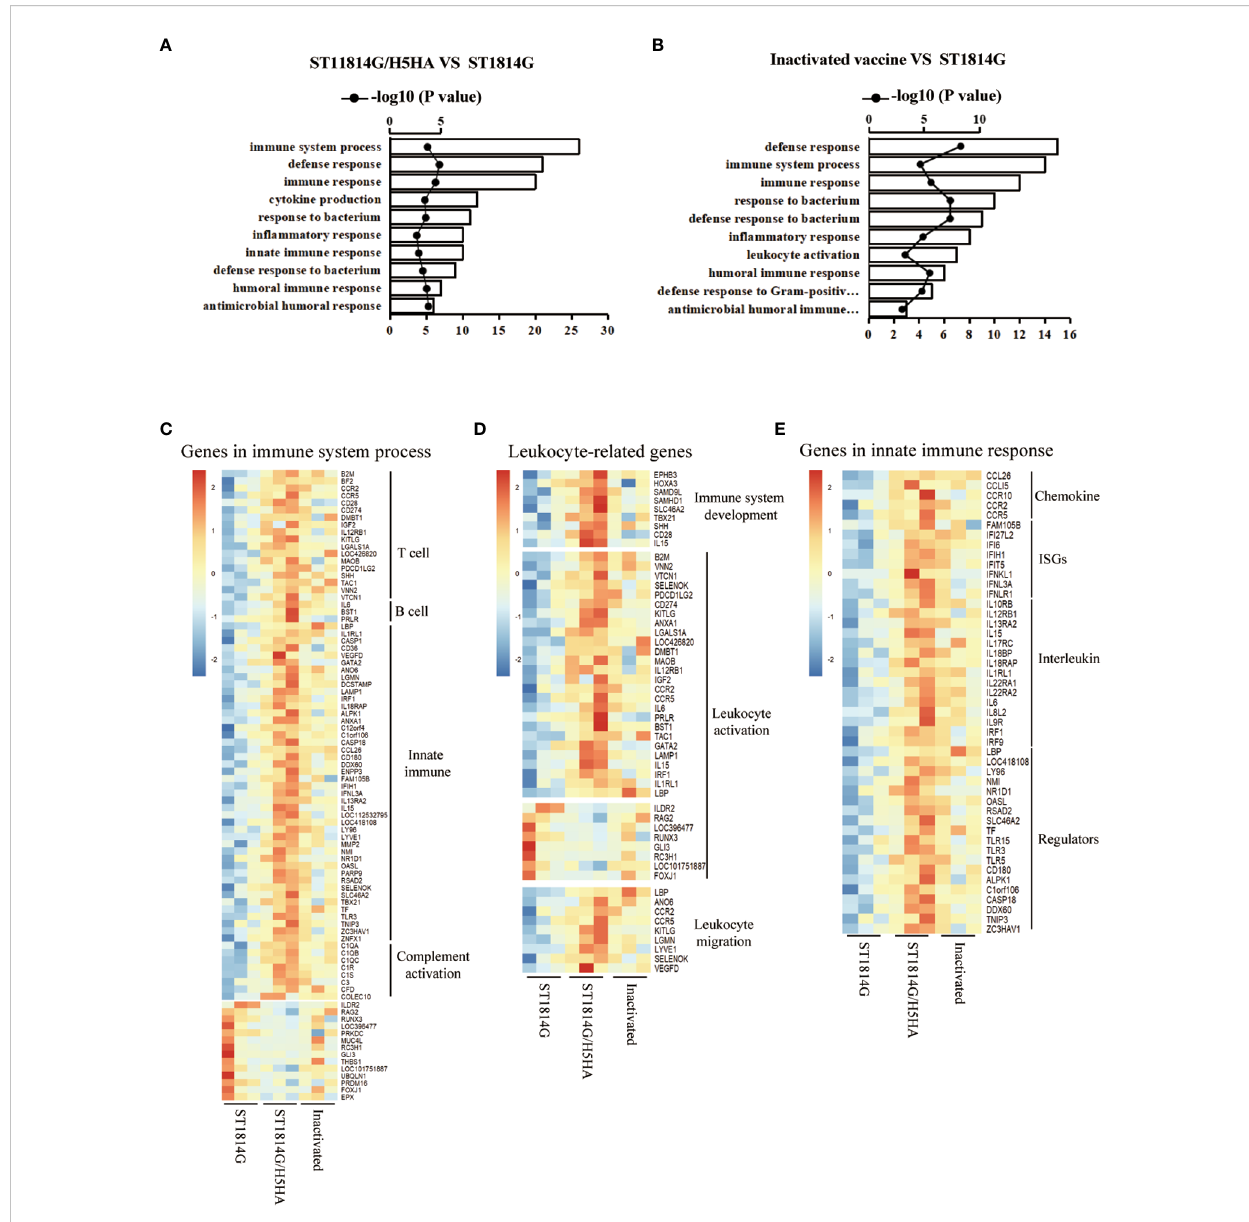
FIGURE 3 Effect of Vaccines on immune related genes of bursa of Fabricius in chickens. (A, B) Biological process analysis of the differentially-expressed genes (DEGs) based on the Gene Ontology databases. Abscissa: biological process; Ordinate: number of genes and – log10 (P value); (A) ST1814G/H5HA group vs ST1814G group; (B) Inactivated vaccine group vs ST1814G group. (C – E) Heatmaps of gene expression levels in BF for indicated gene lists. (C) Genes related to immune system process; (D) Genes related to leukocyte microenvironment of bursa of Fabricius ; (E) Genes related to innate immune